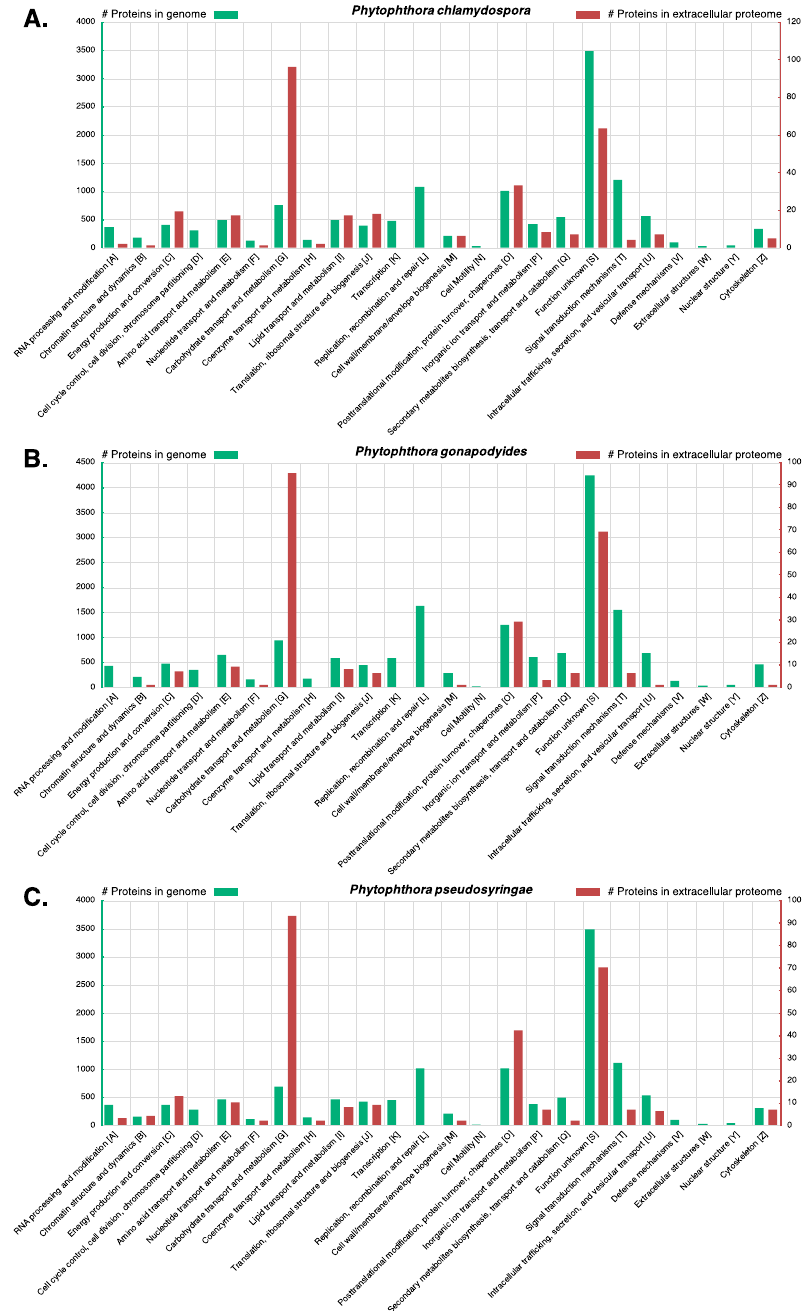
Figure 6. eggNOG functional annotation of the genome and LC-MS/MS extracellular proteome of (A) Phytophthora chlamydospora , (B) Phytophthora gonapodyides and (C) Phytophthora pseudosyringae . Note that counts for extracellular proteins are shown on a secondary axis (right) with a different scale.